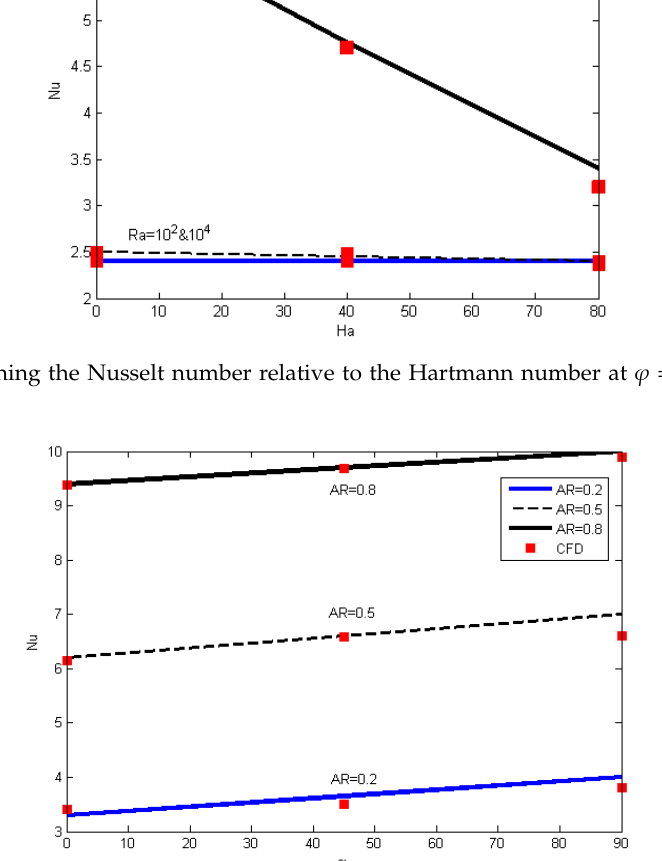
Figure 6. Examining the Nusselt number relative to the Hartmann number at φ = 0.05, AR = 0.5, and α = 0.